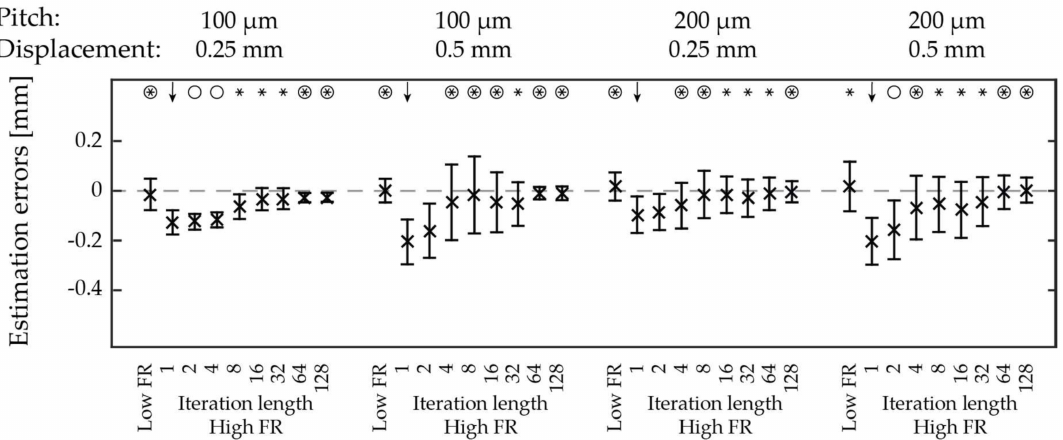
Figure 7. Axial estimation errors of the displacement for two different displacements each using two different pitches (100 µ m and 200 µ m). The crosses indicate the mean estimation error for each setting with the error bars indicating ± one standard deviation. Significant changes ( p < 0.05) were calculated compared to k = 1 in each setting (marked with an arrow). The star indicates a change in the mean estimation error and a circle indicates a change in the standard deviation. FR signifies frame rate: low = 41 Hz, high = 1302